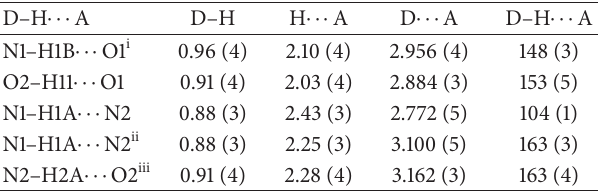
Table 1: Crystal data of 2C